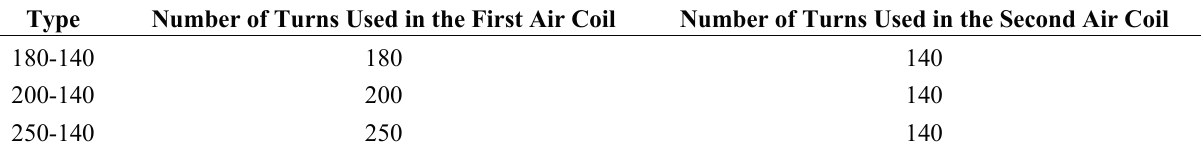
Table 1. Coil turn